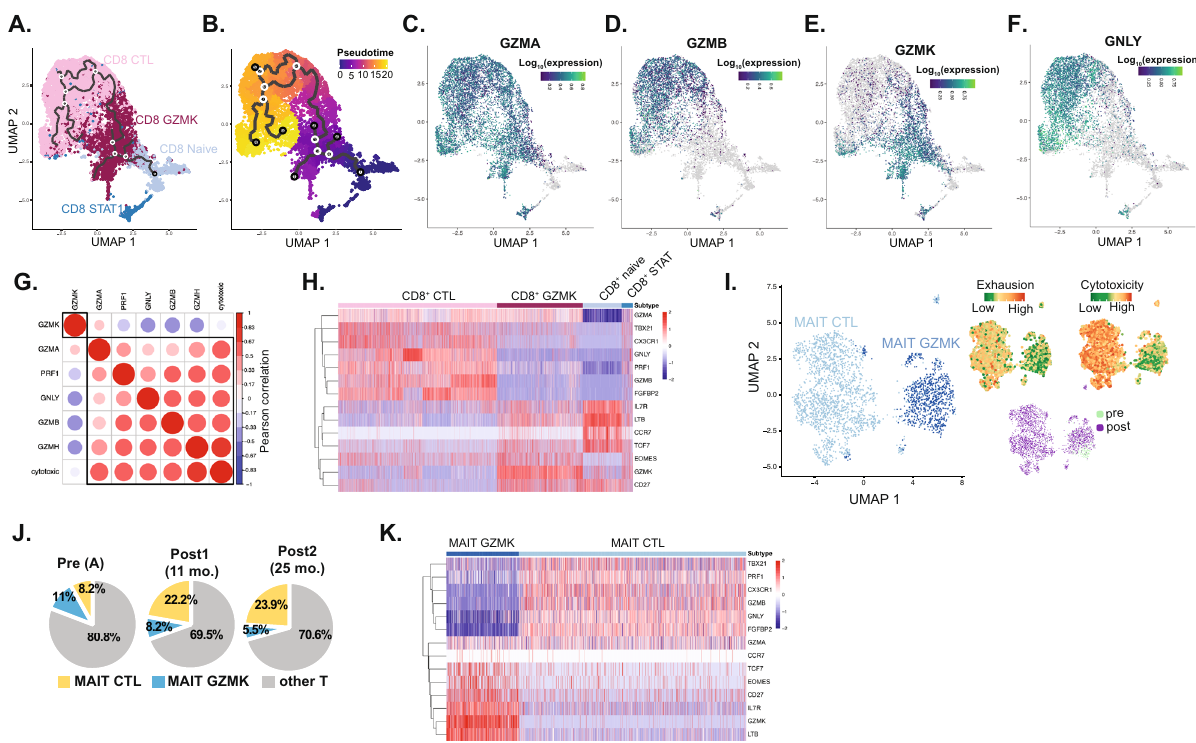
Fig. 4 Trajectory analysis of CD8 + T cells. A , B Monocle3-based pseudotemporal analysis of CD8 + subsets. C – F Expression of GZMA, GZMB, GZMK and GNLY in cells projected onto the trajectory of CD8 + continuum. G Pearson correlation between GZMK and other cytotoxic genes in CD8 + cells. H Heatmap of differentially expressed genes among CD8 + T lymphocyte subsets. I UMAP of MAIT cells with exhaustion and cytotoxicity scores projection. J Distribution of T-cell subsets in PT1. K Heatmap of differentially expressed genes between MAIT